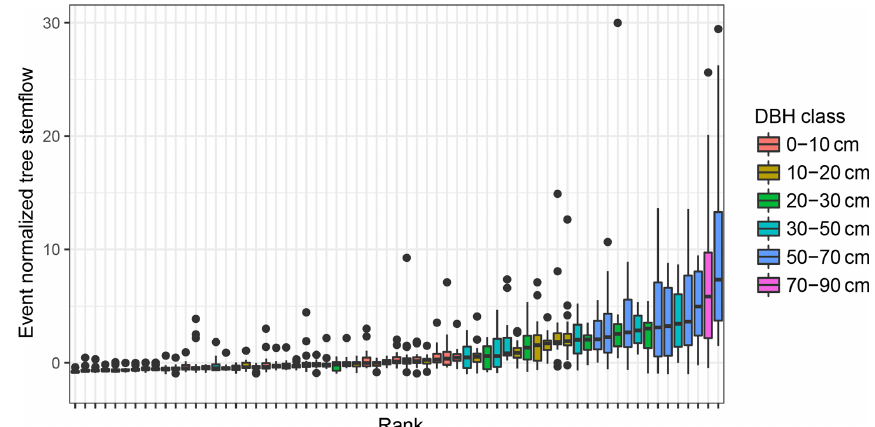
Figure 6. Temporal stability of individual tree stemflow over all sampled events. Trees are ranked according to their median event normalized stemflow and coloured according to DBH (diameter breast height).